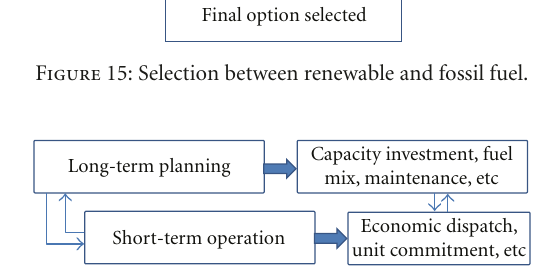
Figure 16: Interaction between long-term and short-term Prob- lems.